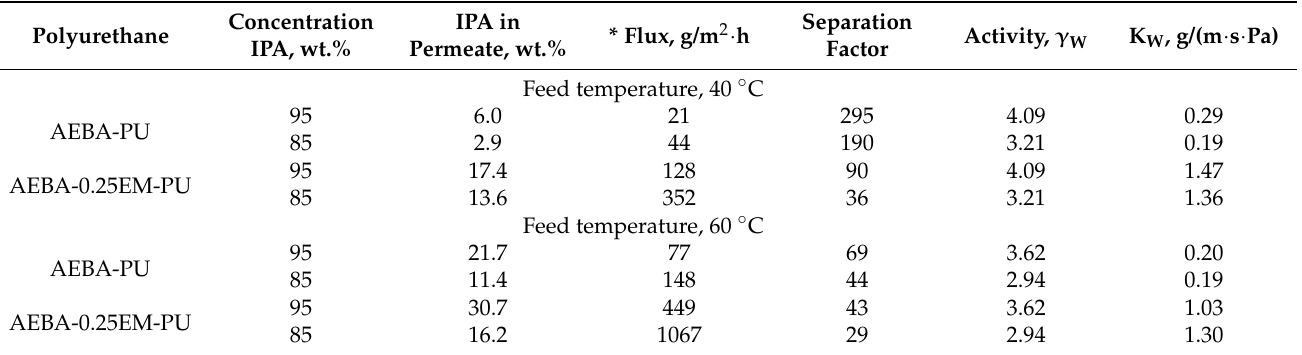
Table 2. Isopropanol dehydration using pervaporation membranes based on AEBA-PU and AEBA- EM-PU.